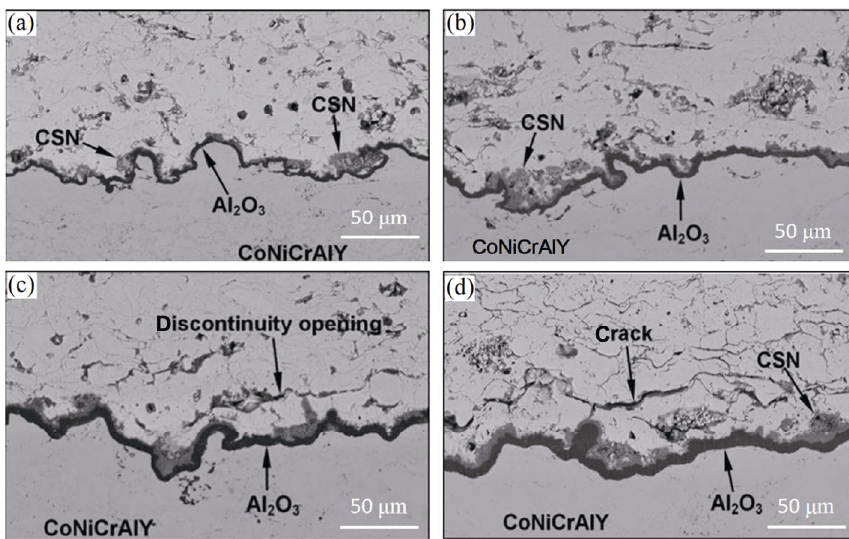
Fig. 38 TGO layer under different cycles: (a) one 100 h cycle, (b) five 100 h cycles, (c) ten 100 h cycles, and (d) twenty-five 100 h cycles. Reproduced with permission from Ref. [202], © ASM International